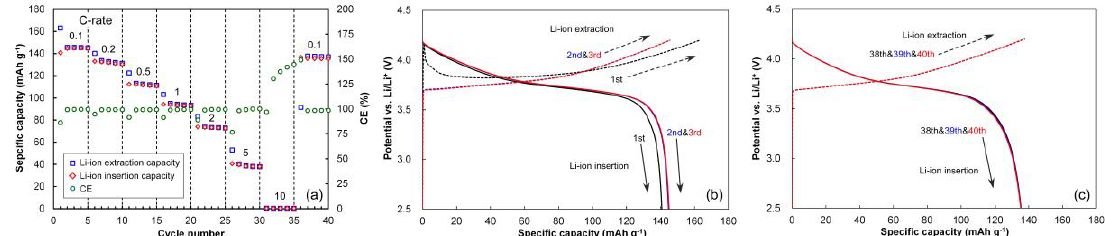
Figure 2. Li-ion extraction-insertion properties of the NCM electrode at various C-rates: ( a ) the specific capacity and the Coulombic efficiency (CE) at 0.1–10 C-rate; ( b ) the potential profiles of the first to third cycles at 0.1 C-rate; ( c ) the potential profiles of the 38th to 40th cycles at 0.1 C-rate. The cut-off potential range was 2.5–4.2 V vs. Li/Li + ; 1 C-rate is equal to 160 mA g −1 .